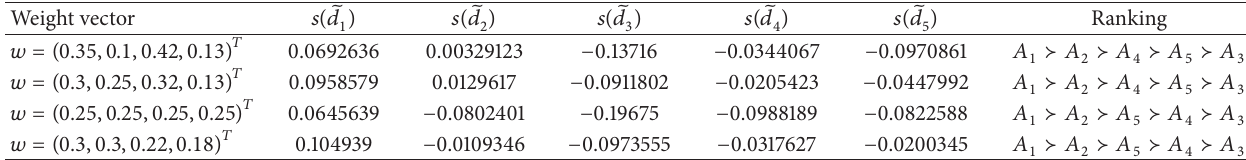
Table 4: Scores for theses obtained by DHFOWG